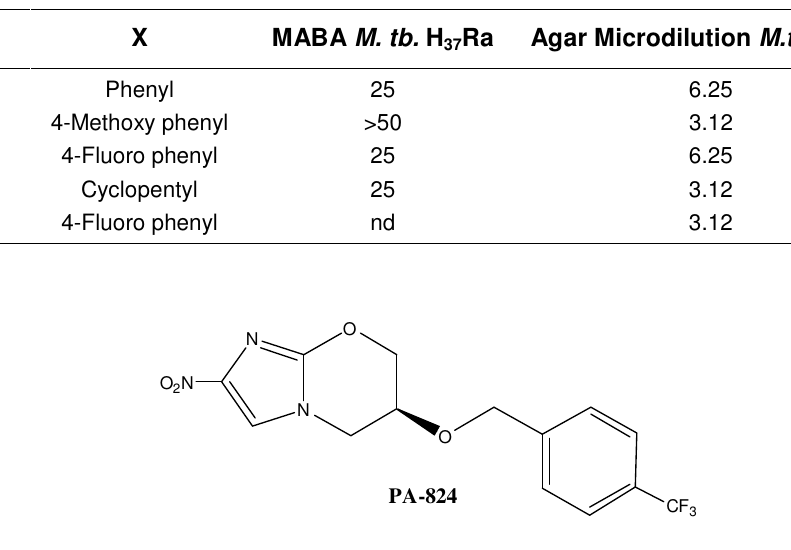
In vitro Anti-TB Activity of More Active Methanone Derivatives 124–126 ( µ g/ml)